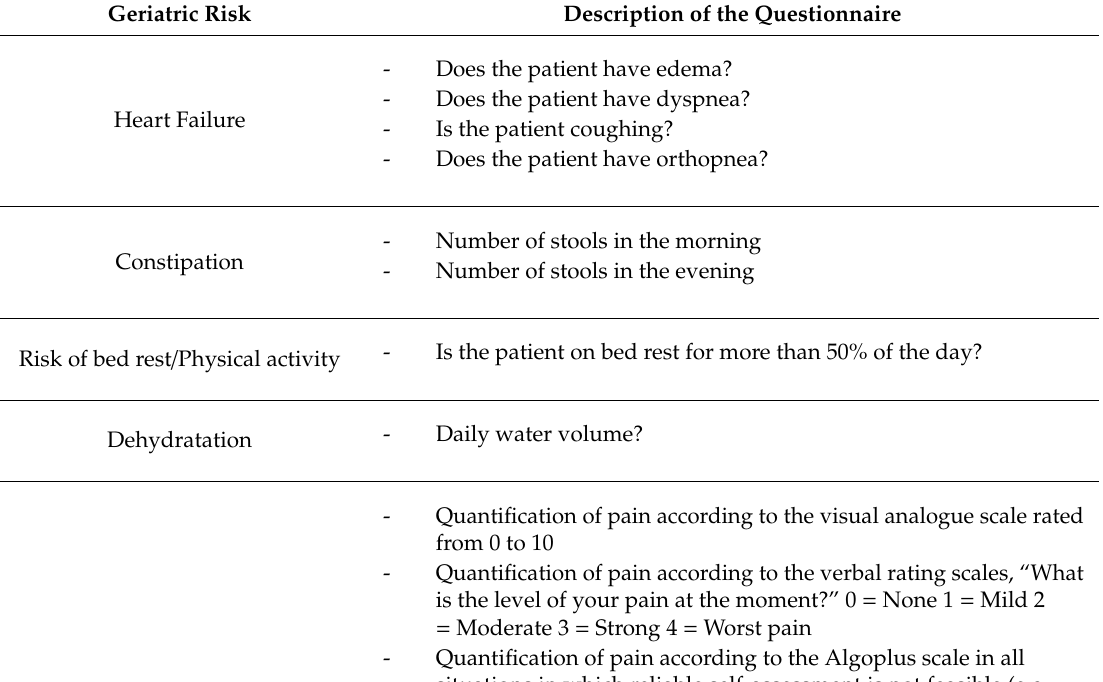
Table 2. Detailed questionnaires included in MyPredi ™ platform. Geriatric Risk Description of the